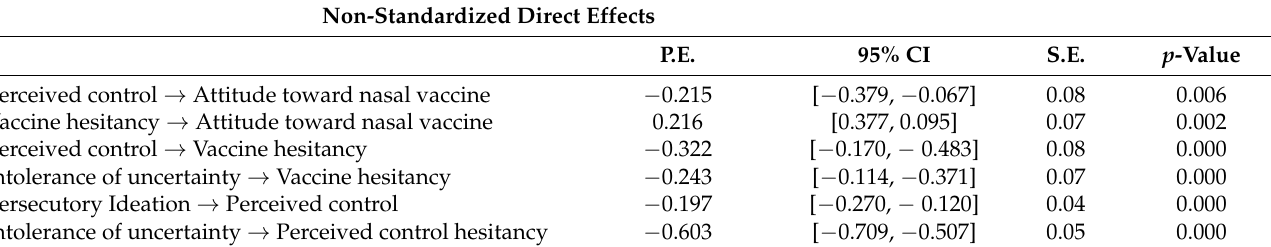
Table 3. Non-standardized direct effects.